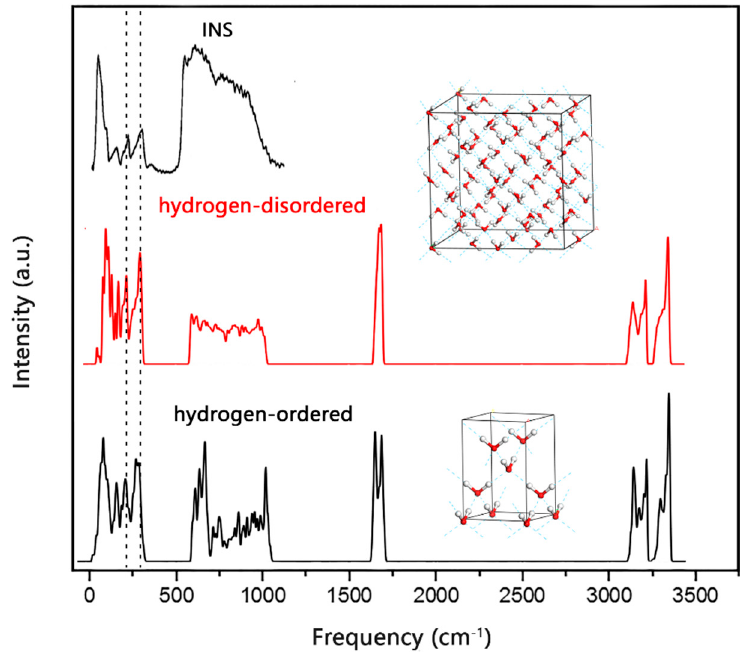
Figure 1. Simulated PDOS spectra of hydrogen-ordered (primitive cell; black curve) and hydrogen- disordered (supercell; red curve) ice Ic. The curve at the top is the INS experimental spectrum. The agreement of the two hydrogen bond peaks in these three spectra is marked with dashed lines. The 64-molecule supercell of ice Ic and the unit cell of the hydrogen-ordered model are inserted.